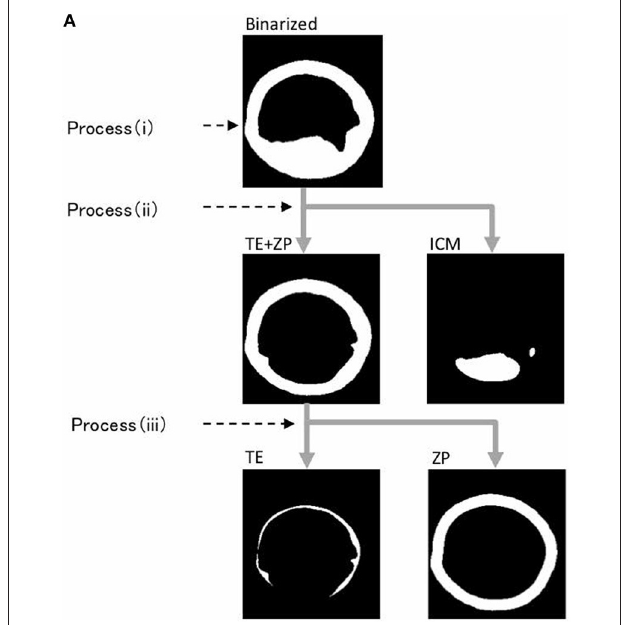
Production of Embryos Derived From Oocytes Collected by Ovum-Pick-Up (OPU) and in vitro Maturation (IVM) As described previously (39), cumulus-oocyte complexes